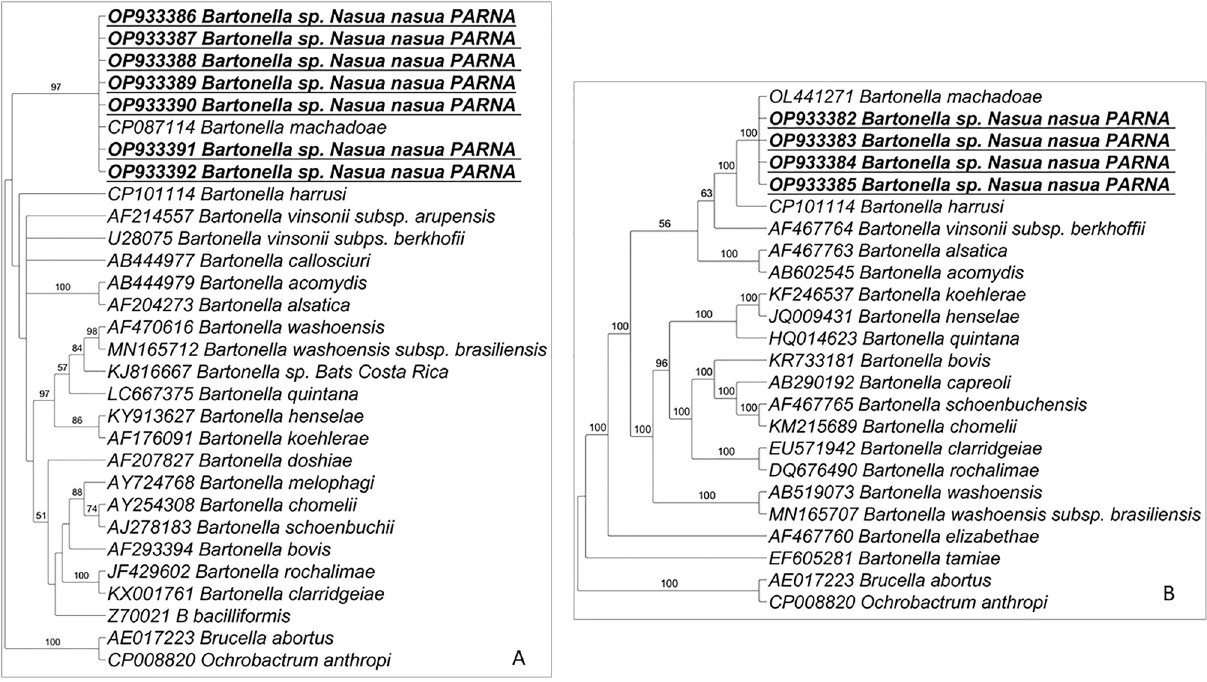
Figure 4. Phylogenetic trees based on the Maximum likelihood method from Bartonella spp. sequences obtained from blood from ring-tailed coatis ( Nasua nasua ) from PARNA. Sequences of Bartonella sp. detected in the present study are highlighted in bold/underlined ( A ) gltA gene; Brucella abortus and Ochrobactrum anthropi were used as outgroup; ( B ) ftsZ gene; Brucella abortus and Ochrobactrum anthropi were used as